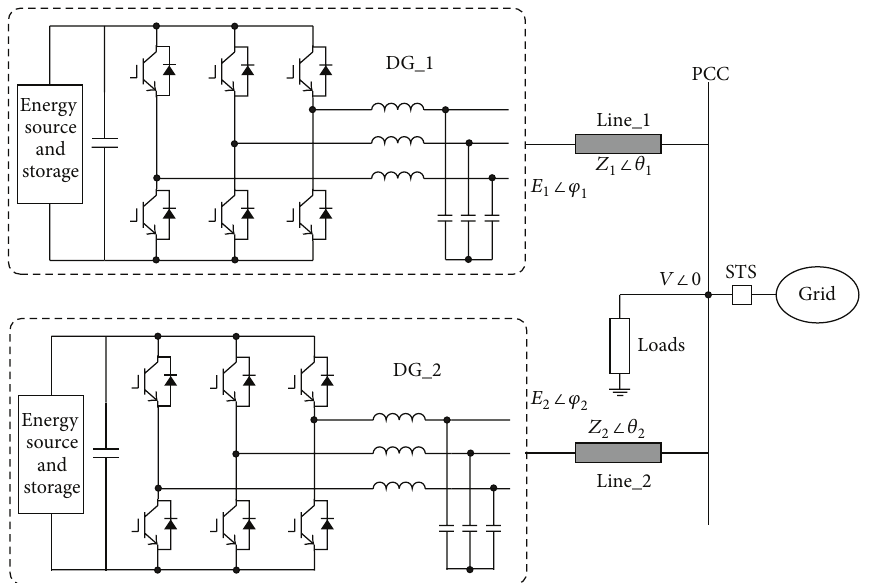
Figure 1: Schematic diagram of inverter-based